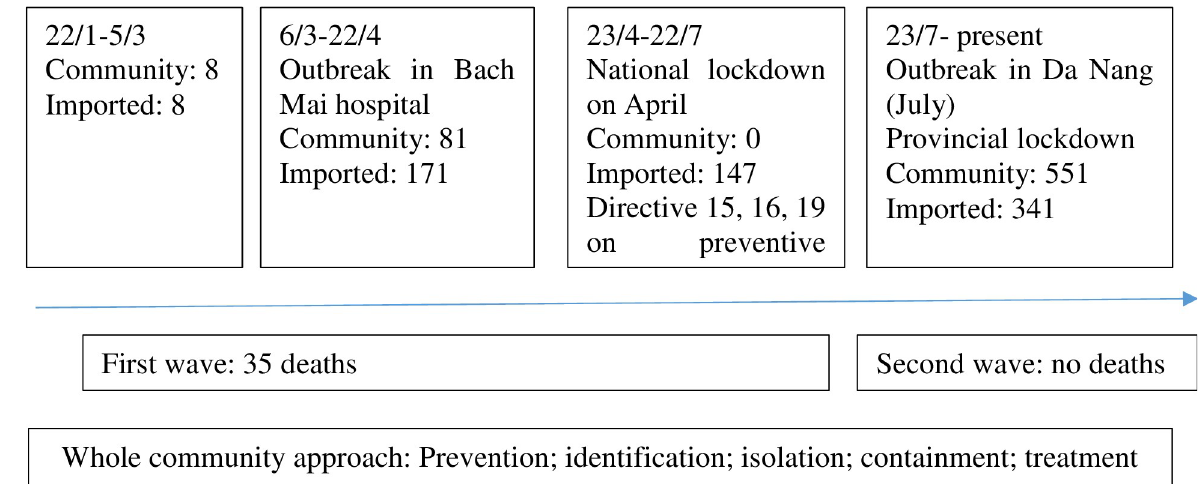
Fig 1. Timeline of COVID-19 in Vietnam by November 30,